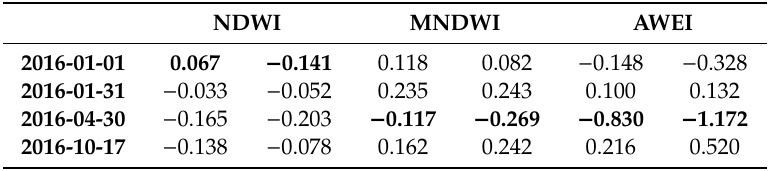
Figure 9. Comparison of water feature segmentation results for the MNDWI image on April 30th. Left side: with pixel selection technique; right side: without pixel selection technique. Table 7. Otsu method derived thresholds for WIs. Left column: with pixel selection; right column: without pixel selection. Thresholds that lead to major difference are highlighted.